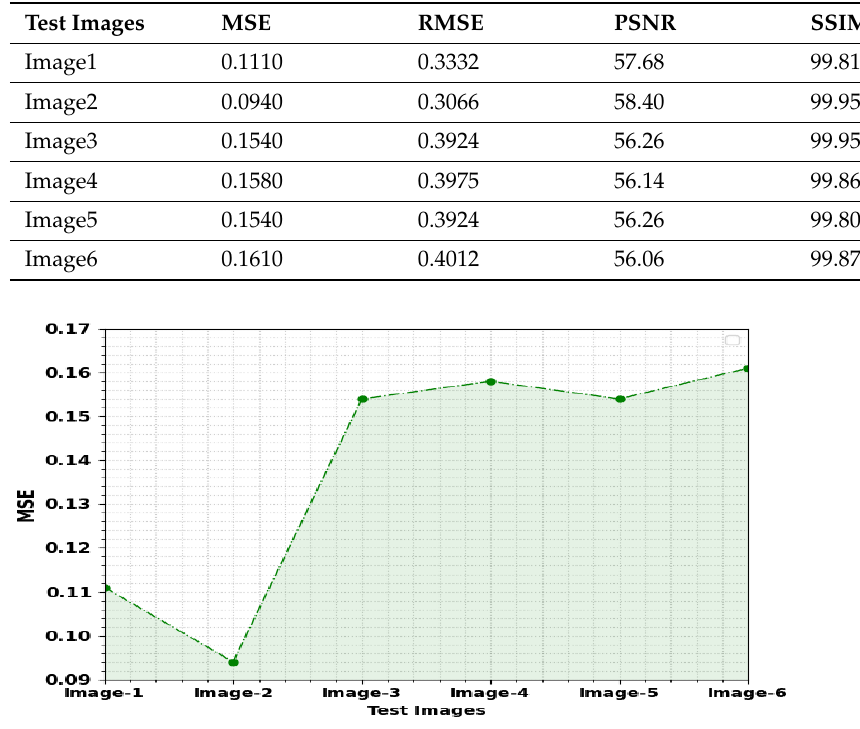
Figure 4. Result analysis of the PPIE-ODLASC system with distinct images. Table 3 and Figure 5 represent the PSNR results of the PPIE-ODLASC system with and without attacks. The outcome indicated that the PPIE-ODLASC algorithm has obtained effectual PSNR values under the presence of attack. For sample, in image1, the PPIE-ODLASC approach has obtained a PSNR of 57.68 dB and 56.73 dB for without and with attacks, respectively. Concurrently, on image3, the PPIE-ODLASC method has gained a PSNR of 56.26 dB and 55.14 dB for without and with attacks, correspondingly. Furthermore, in image6, the PPIE-ODLASC model has obtained a PSNR of 56.06 dB and 54.98 dB for without and with attacks, correspondingly. Table 3. PSNR analysis of the PPIE-ODLASC system under with and without attacks. Test